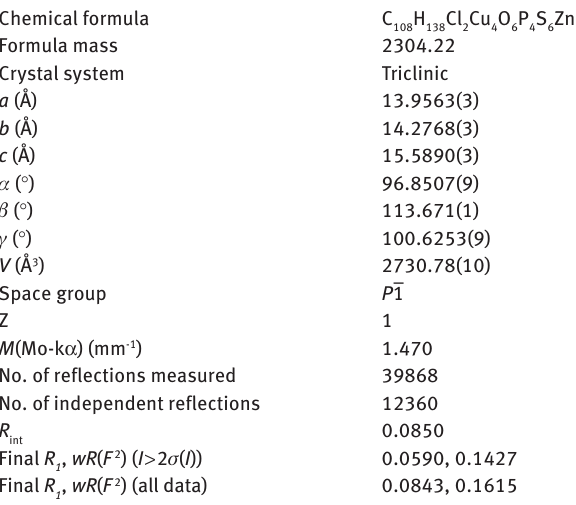
Table 2: Crystal data and structure refinement for 1 .